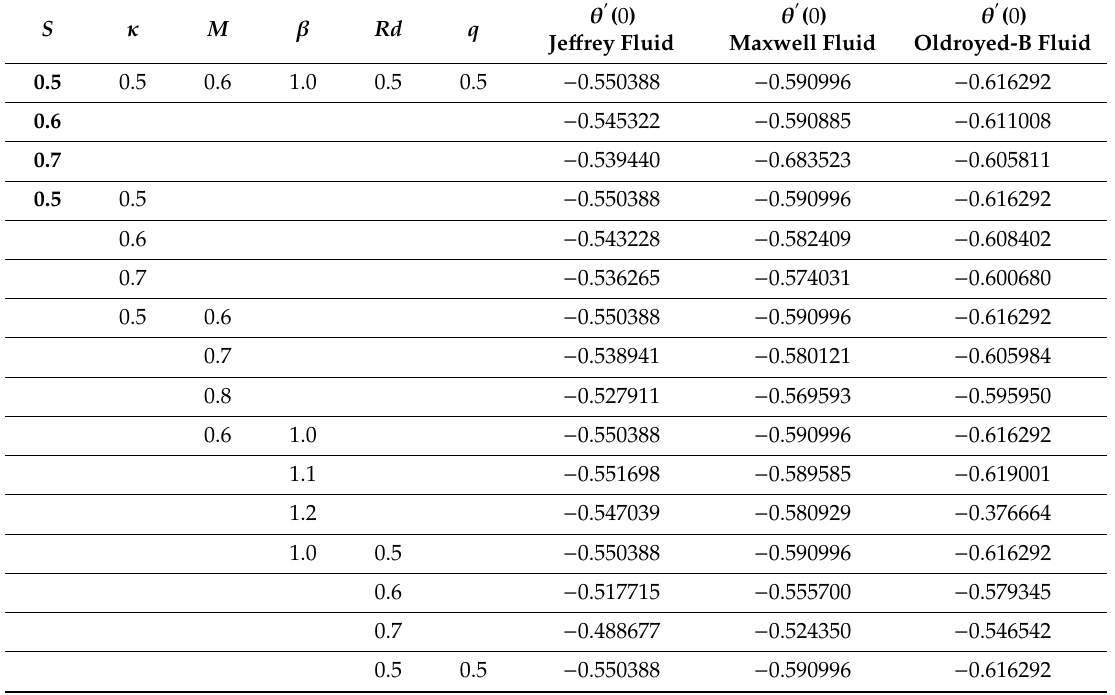
Table 5. Numerical values of the local Nusselt number for several physical parameters,